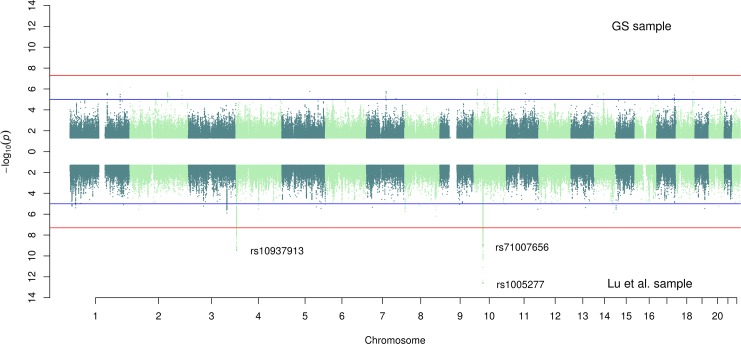
Miami plot for GWAS of Hannum-EAA in the GS and Lu et al. cohorts.SNP-based Miami plot comparing the results of genome-wide association analyses of Hannum-based epigenetic age acceleration in GS (top, n = 5,100) and Lu et al. (bottom, n = 8393), with—log10 transformed P-values for each SNP plotted against chromosomal location. The red line indicates the threshold for genome-wide significance (P<5×10−8) and the blue line for suggestive associations (P<1×10−5). Independent significant SNPs are annotated.